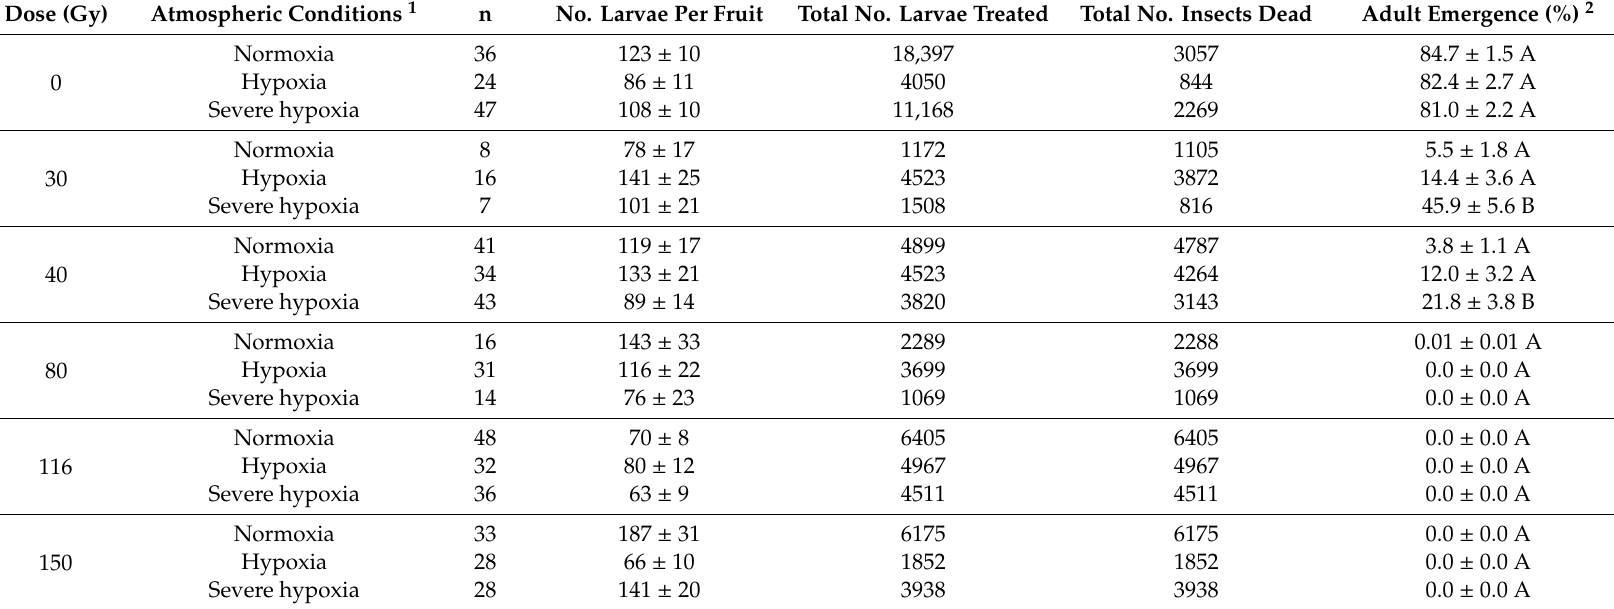
Table 3. Numbers of replicates, larvae per fruit (mean ± SE), treated larvae, dead insects, and adult emergence (mean ± SE) of Bactrocera dorsalis third instars irradiated at di ff erent nominal doses and atmospheric